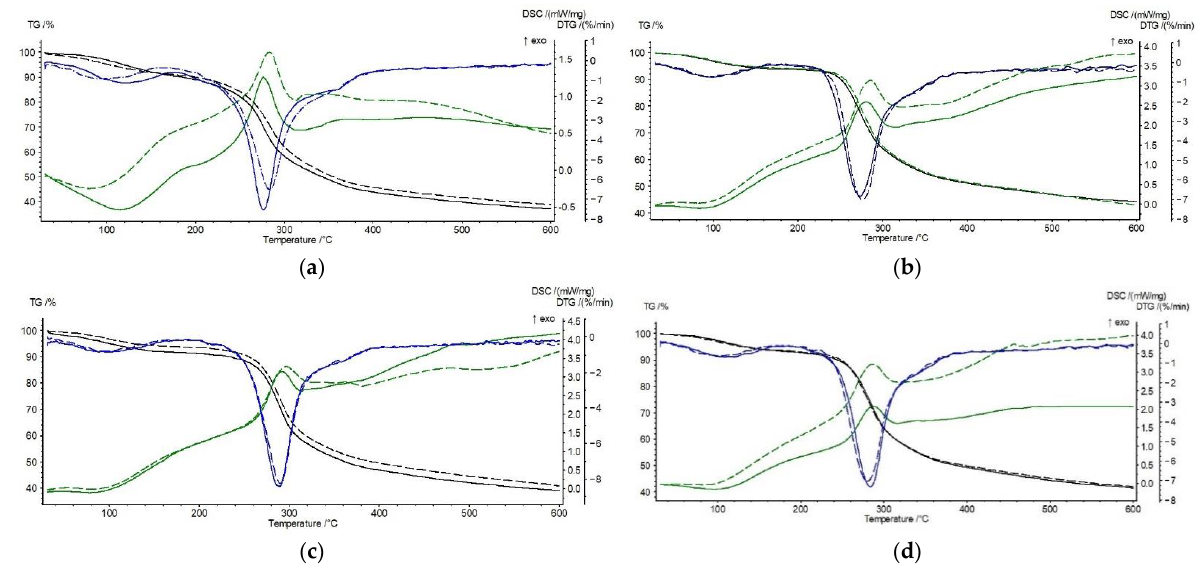
Table 3. Thermal parameters of 8 h UV irradiated chitosan and modified chitosan samples deter- mined from TGA analysis.